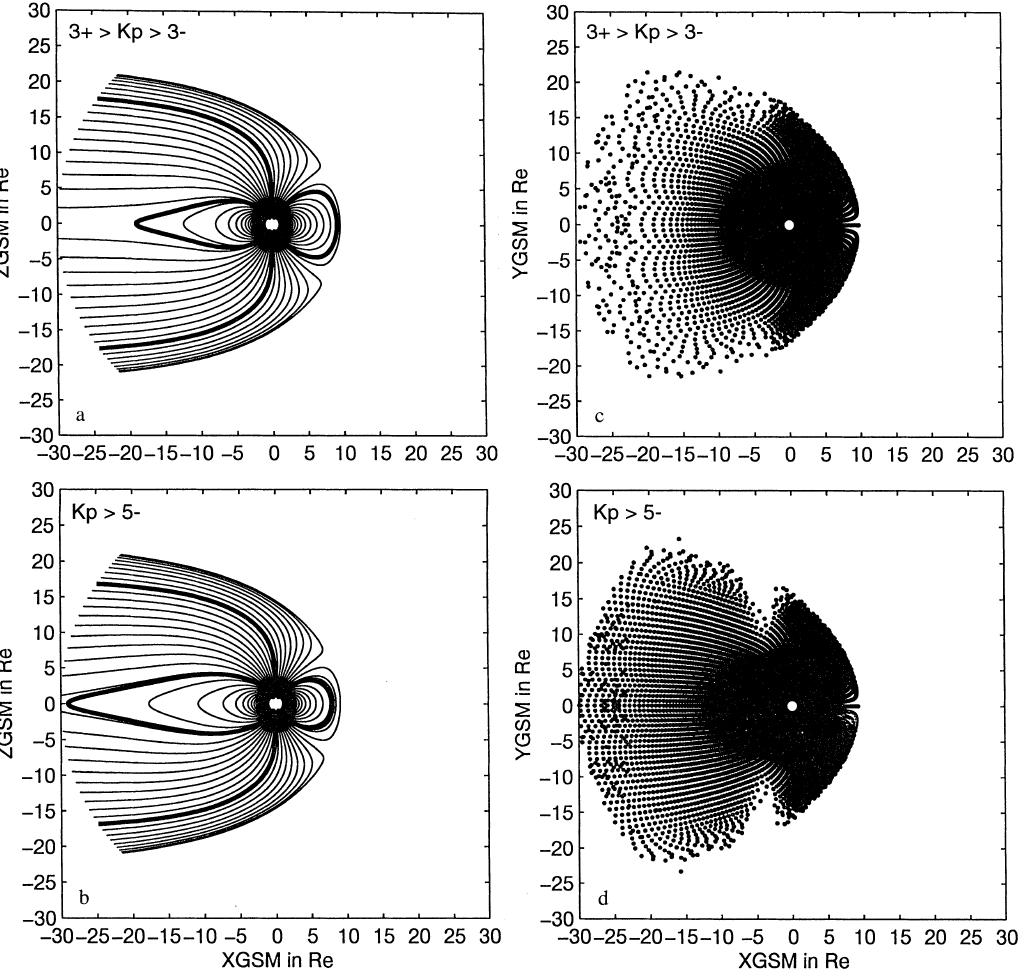
Fig. 1a–d. Field lines in the XGSM-ZGSM plane of the Tsyganenko (1987) magnetic field model every 2 (cid:14) invariant magnetic latitude from the North Pole with the dipole field as the main field and zero geodipole tilt angle. The bold lines correspond to the poles at high latitudes and to the external boundary of the considered domain at low latitudes. a Corresponds to 3 (cid:255) < Kp < 3 (cid:135) where the external